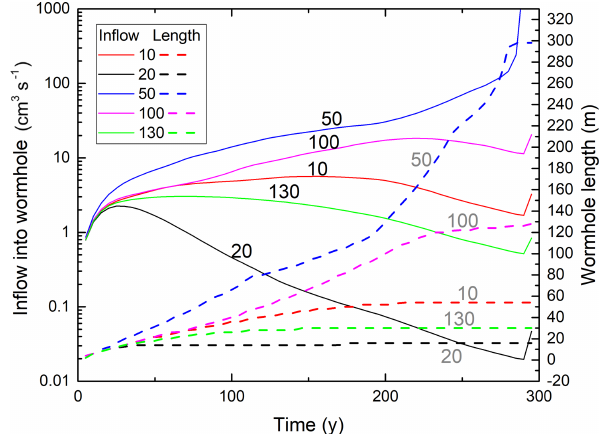
Figure 18. Evolution of input flow rates (solid lines) and wormhole lengths (dashed lines) for the wormholes marked in Fig. 17. Num- bers on curves denote the y coordinates of the